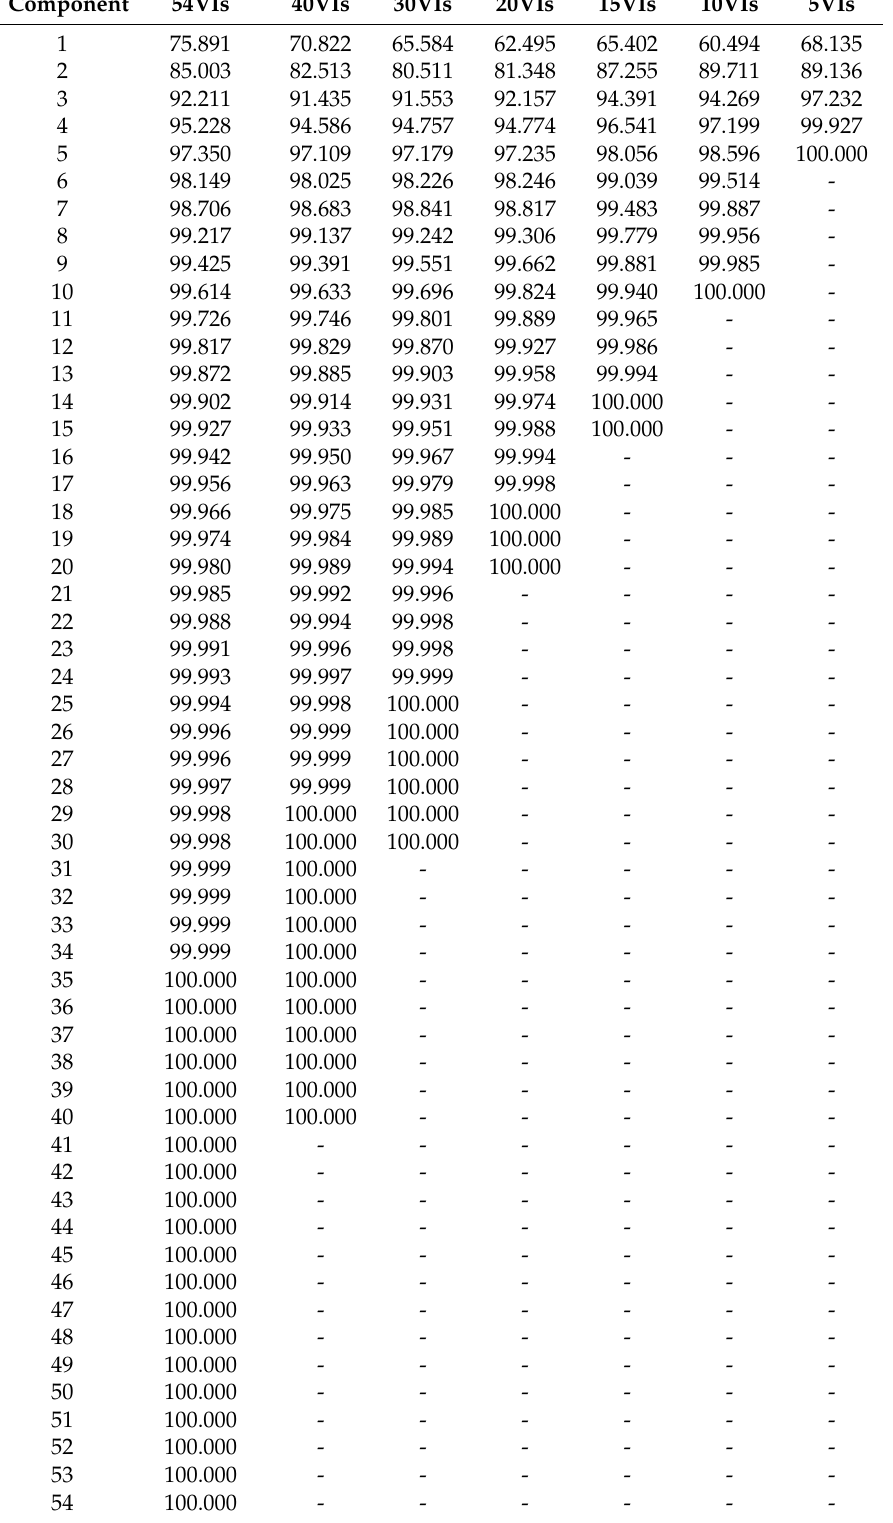
Table A1. Total explained variance of each group of VIs